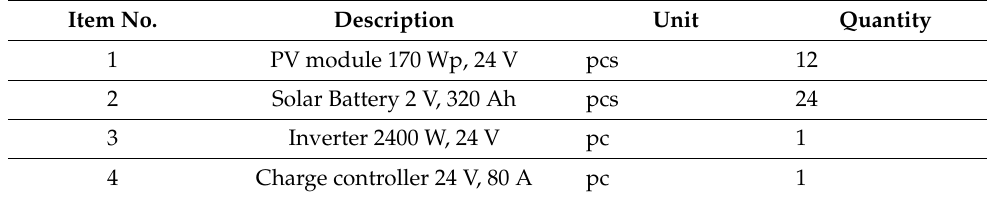
Table 2. Components of the health center PV system